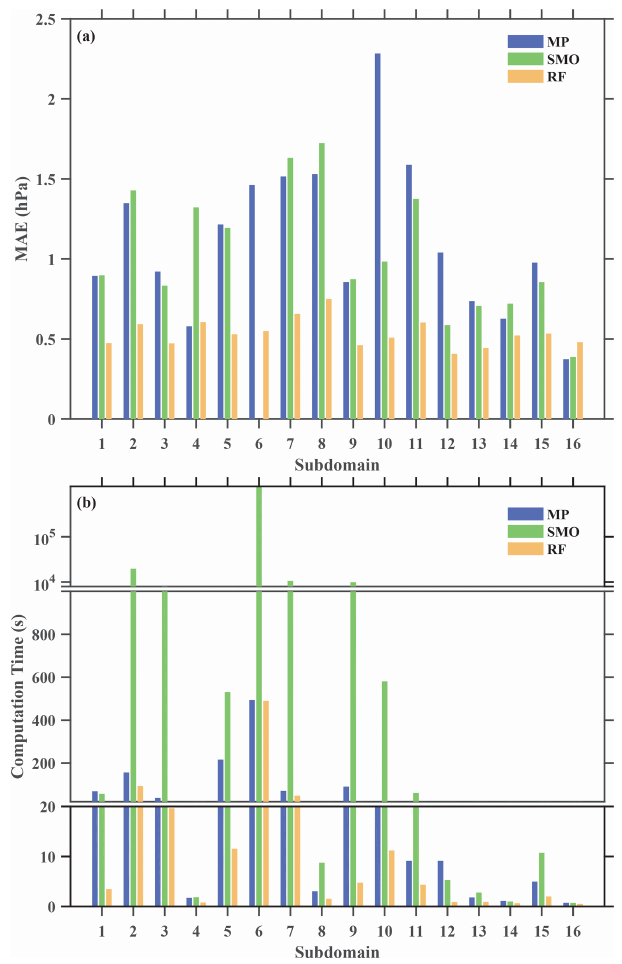
Figure 9. (a) Mean absolute error (MAE) distribution at different training subdomains for different machine-learning methods (MP refers to multilayer perception method; SMO refers to support vec- tor machine method; RF refers to random forest method). Panel (b) is the same as (a) but for computation